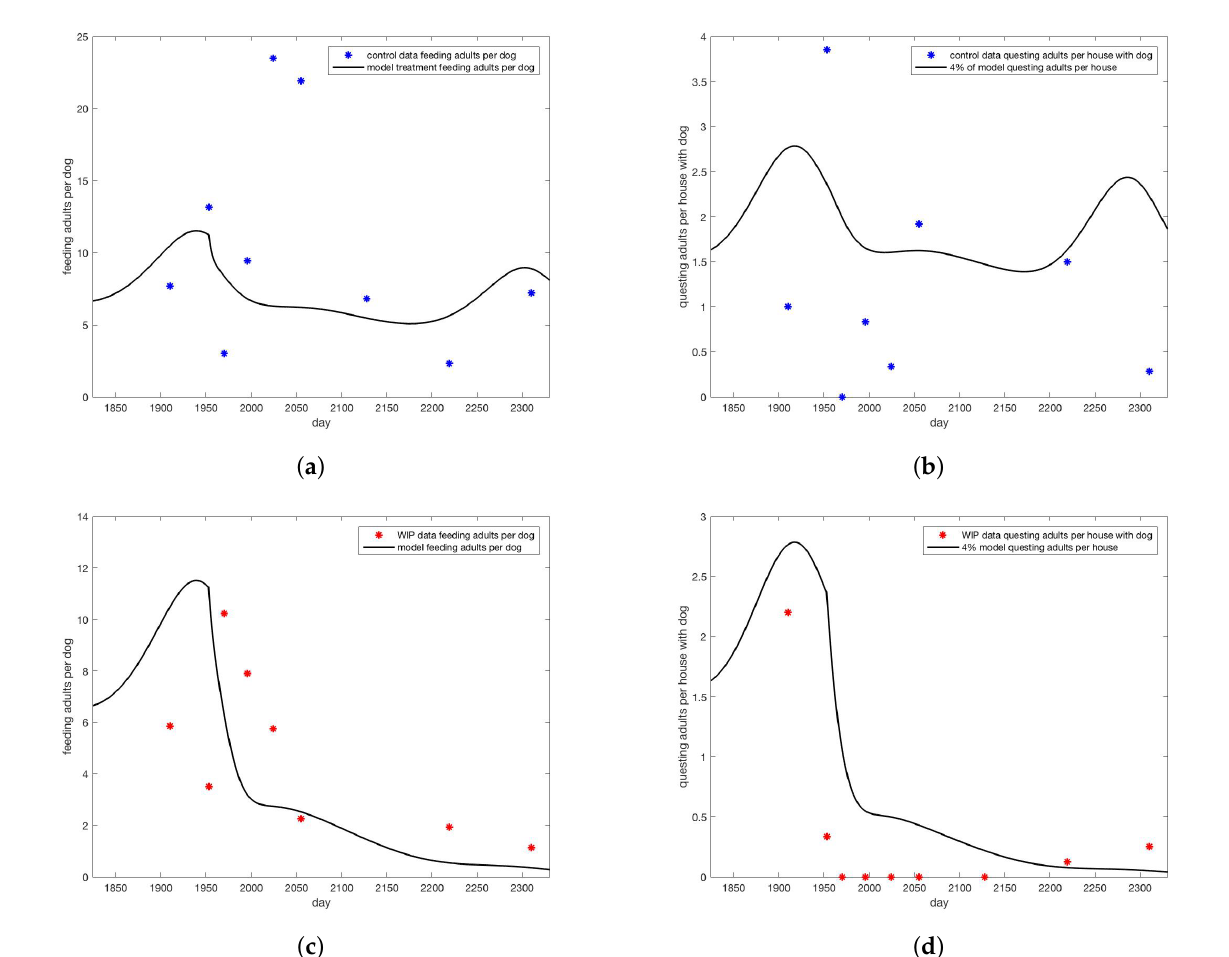
Figure 4. Model versus data for ( a ) adults on dogs for control and ( b ) on walls of houses with dogs for control. Data are blue dots, model trajectory is the black curve. For the data 80% coverage in collars was noted and no wall treatment. For the model, 8% coverage of dog collars ( c = 0.08) was used and no wall treatment ( j = 0). Model versus data for ( c ) adults on dogs for WIP full height insecticidal paint. Data are red dots, model trajectory is the black curve. ( d ) on walls of houses with dogs for WIP full height insecticidal paint. Data are red dots, model trajectory is the black curve. For the data 80% coverage in collars was noted and 15% wall treatment. For the model, 8% coverage of dog collars ( c = 0.08) was used and 3.75% wall treatment ( j = 0.0375). Note that for counts of ticks on walls, 4% of model value was shown for visual